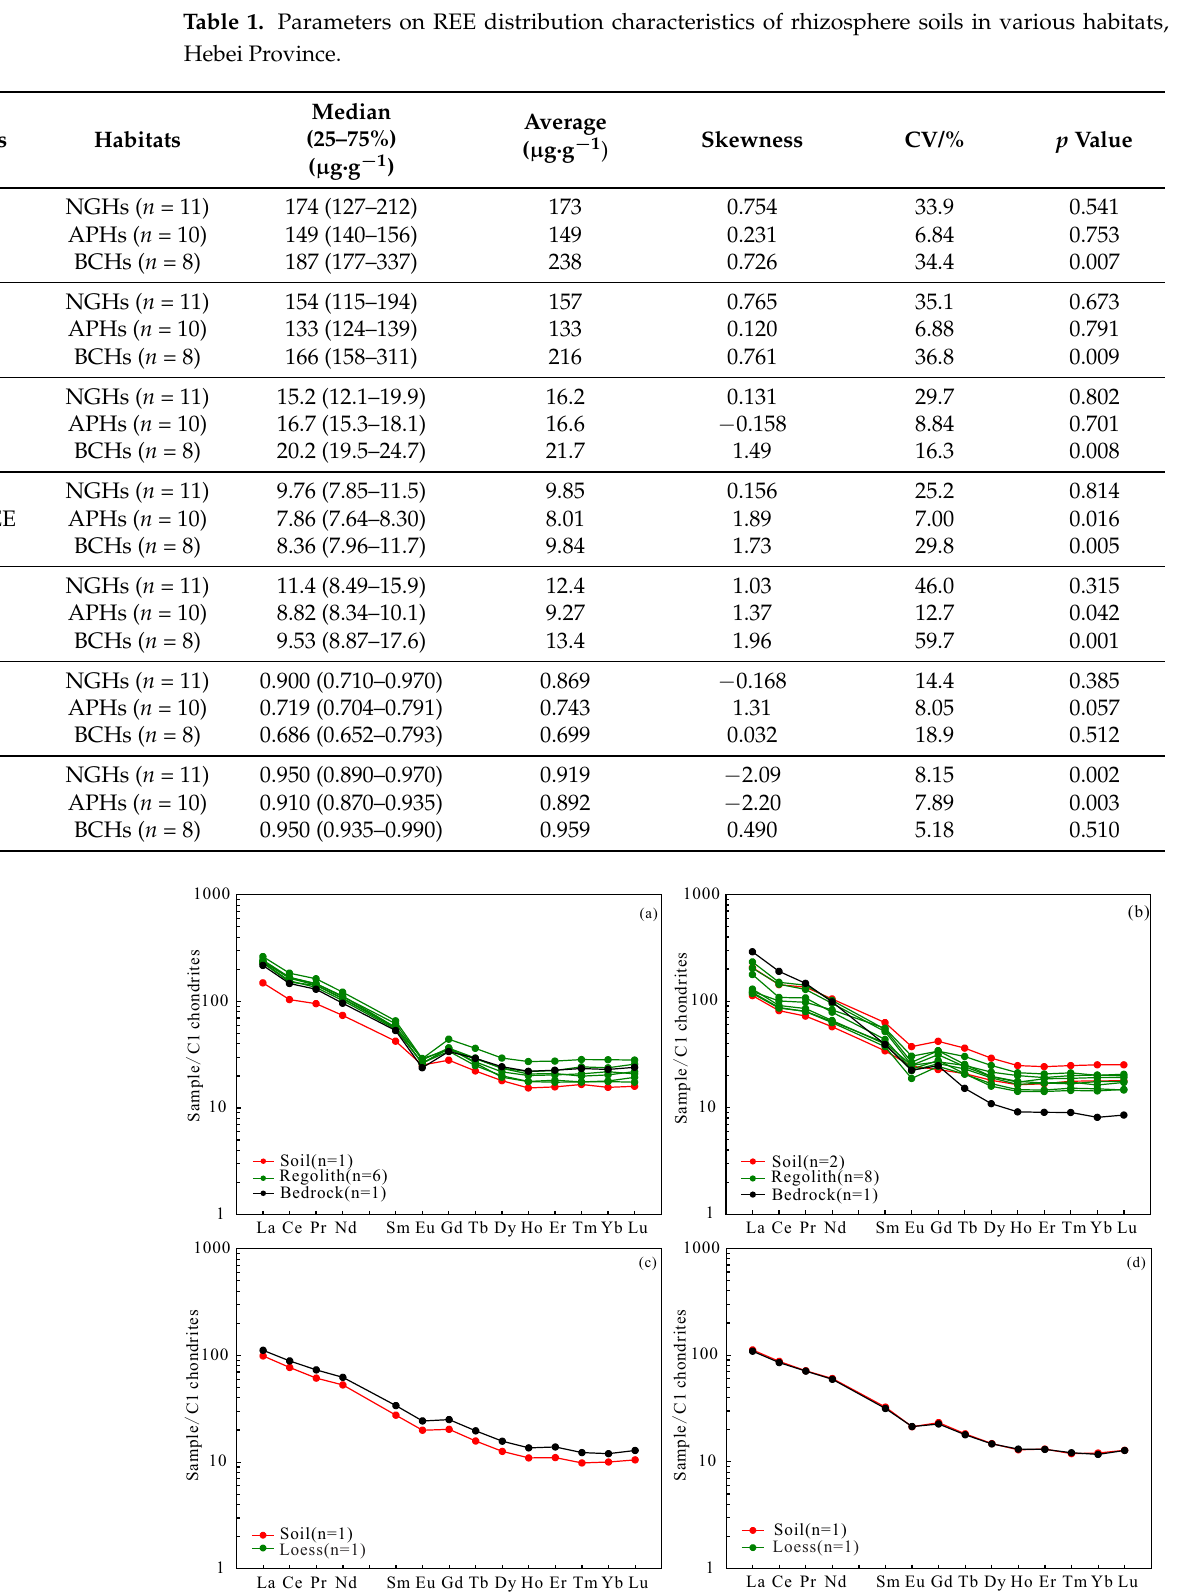
Figure 4. Chondrite-normalized REE patterns of layers along profiles. ( a ) Chondrite-normalized REE patterns along profile 1 in NGHs; ( b ) Chondrite-normalized REE patterns along profile 2 in NGHs; ( c ) Chondrite-normalized REE patterns along profile 3 in APHs; ( d ) Chondrite-normalized REE patterns along profile 4 in